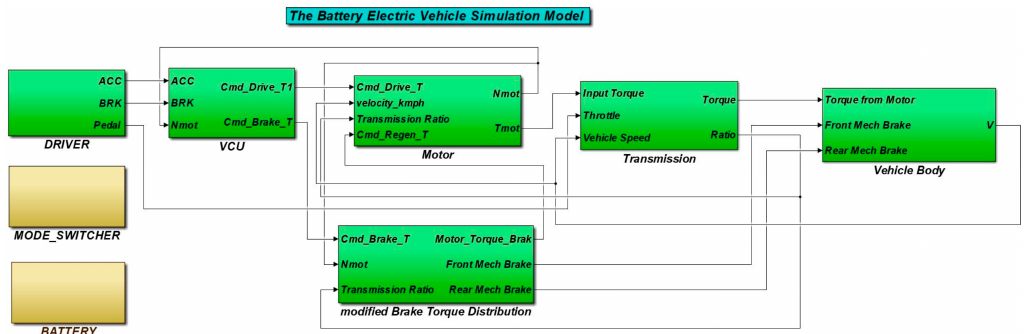
Figure 4. Upper layer of the BEV Simulink ®